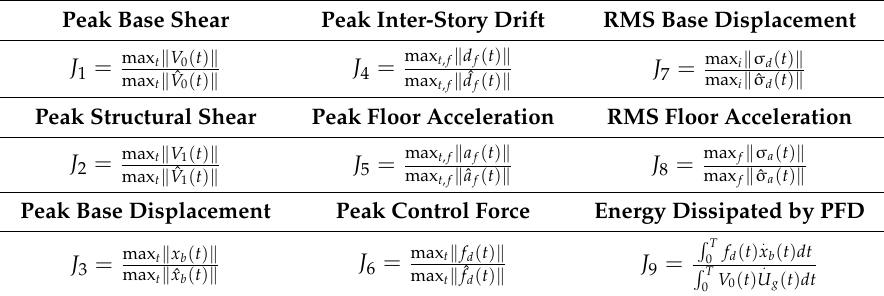
Table 6. Performance